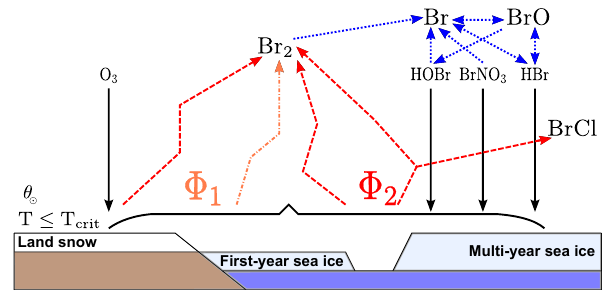
Figure 1. Schematic scenario of bromine release from first-year sea ice, multi-year sea ice, and land snow adapted from Toyota et al. (2011) for a temperature threshold T crit . Black arrows denote dry deposition of HOBr, BrNO 3 , HBr, and O 3 . Blue dotted arrows in- dicate gas-phase photochemistry. Dry deposition fluxes are recycled into Br 2 with respect to a molar yield (cid:56) 1 in the case of O 3 (dashed orange) and (cid:56) 2 in the case of the brominated species (dashed